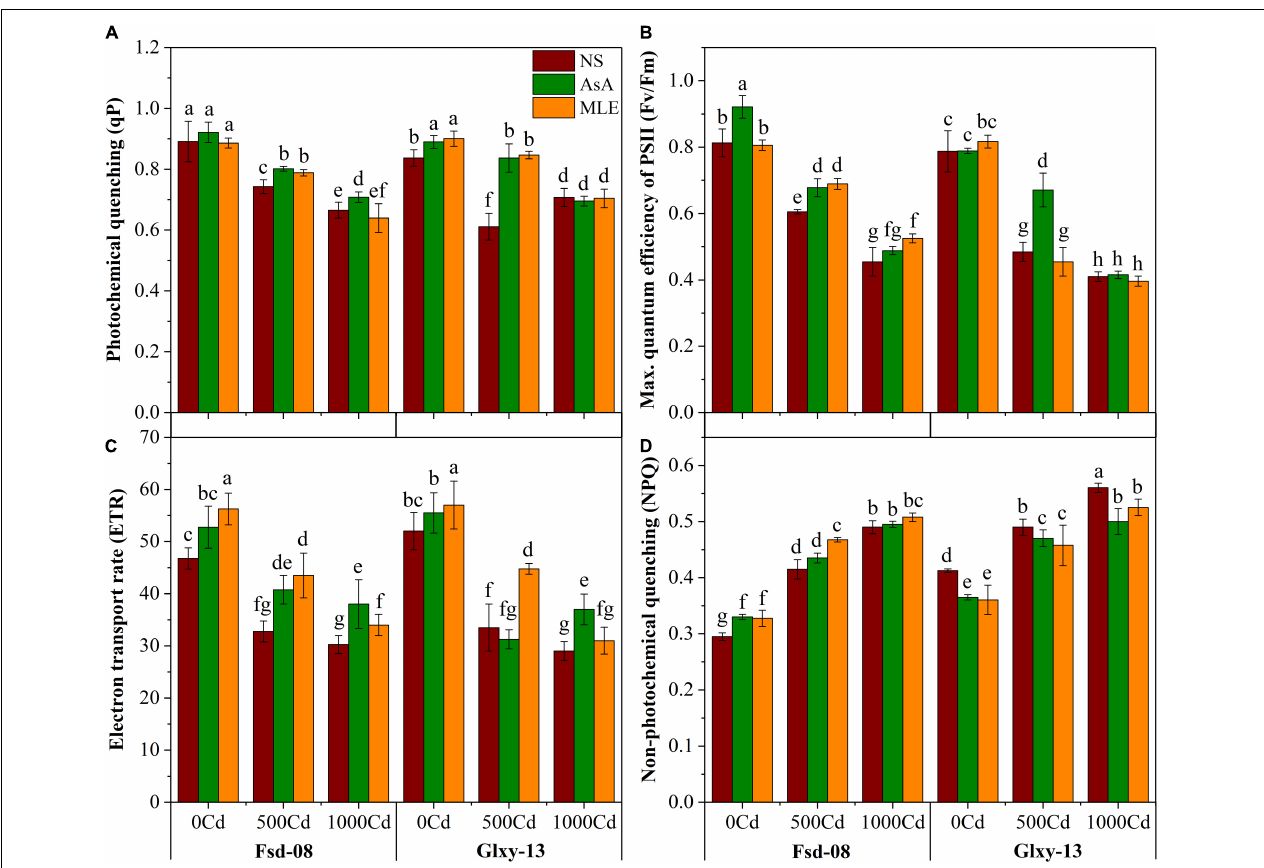
FIGURE 2 | Chlorophyll fluorescence responses as (A) photochemical quenching (qP), (B) maximum quantum efficiency of PSII (Fv/Fm), (C) electron transport rate (ETR), and (D) non-photochemical quenching (NPQ), under the foliar spray of AsA and MLE, along with N) in two wheat cultivars (Fsd-08 and Glxy-13) exposed to the Cd toxicity. Different lowercase letters denote significant difference as determined by LSD test ( p < 0.05, n = 4). AsA and MLE were applied at the rate of 50 mM and 3% (w/v),